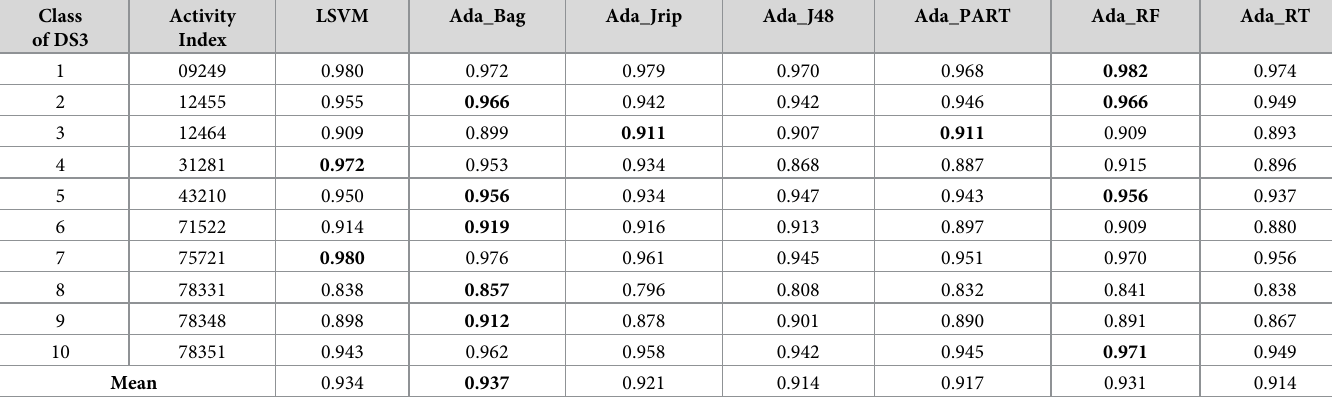
Table 6. Sensitivity measure for the prediction of new bioactive molecules with DS3 (heterogeneous).